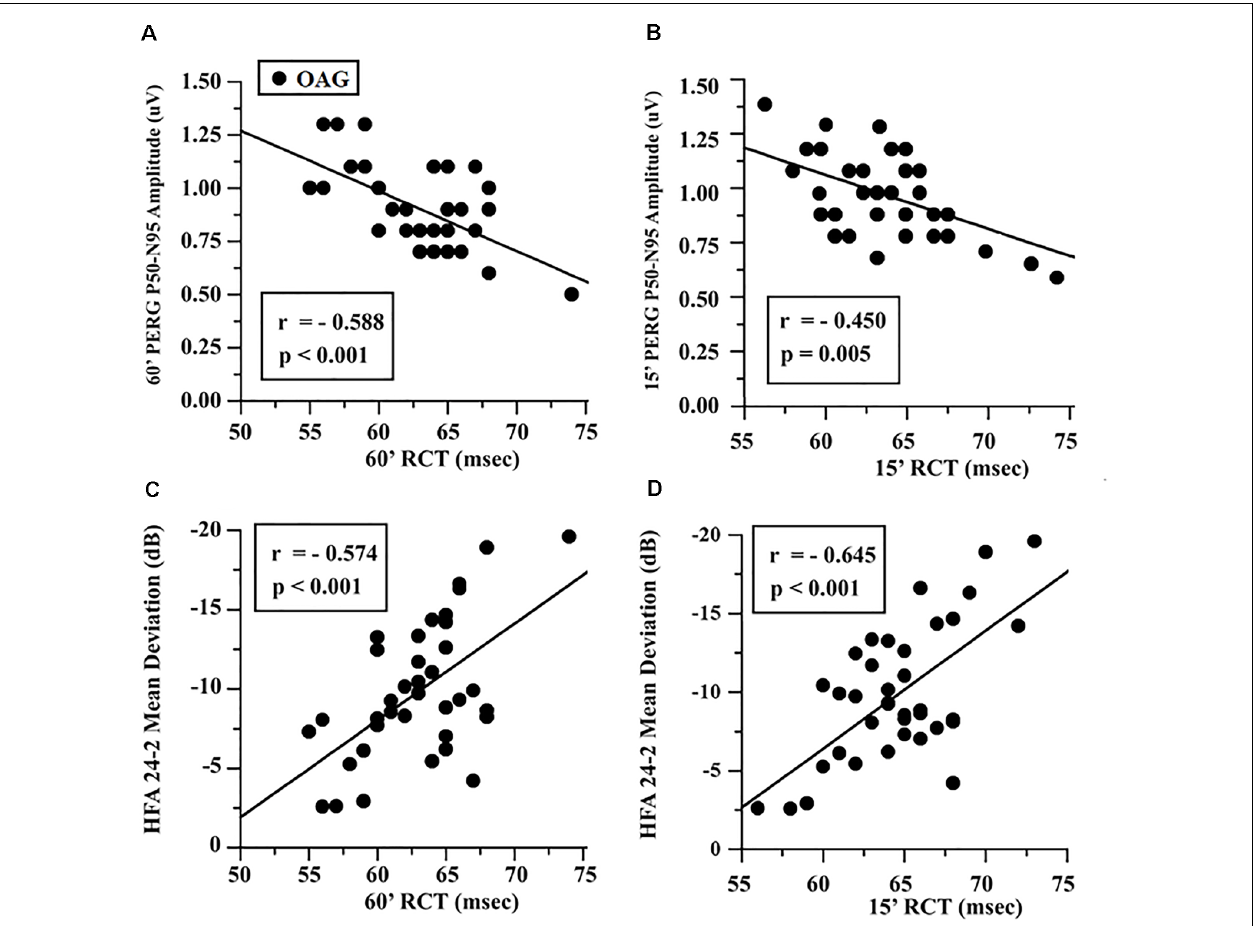
FIGURE 2 | OAG eyes: linear correlation between retinocortical time (RCT) and pattern electroretinogram (PERG) P50-N95 amplitudes (A,B) and Humphrey Field Analyzer (HFA) 24-2 mean deviation (C,D) . RCT, difference VEP 100 minus PERG P50 implicit times; 60 (cid:48) and 15 (cid:48) , visual stimuli with checks subtending 60 and 15 min of visual arc, respectively; msec, milliseconds; µ V, microvolt.